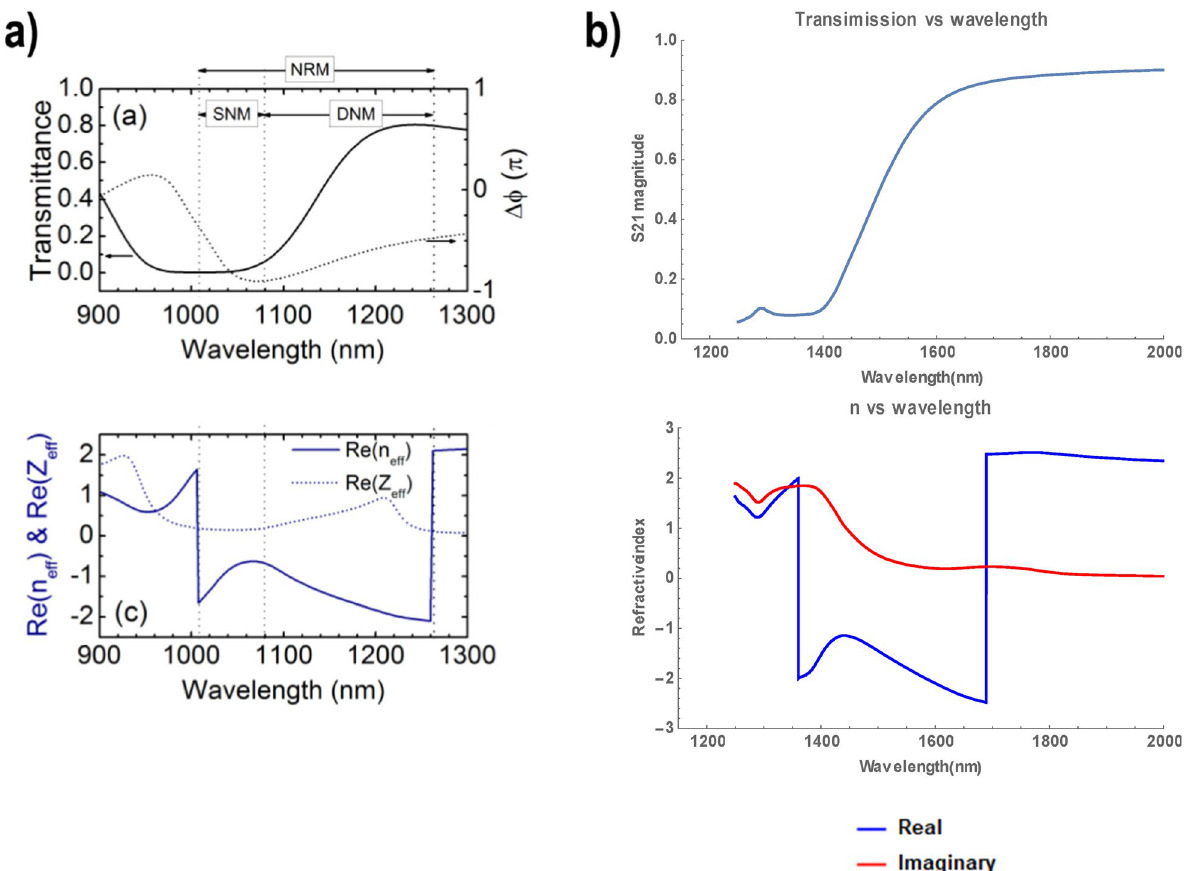
Figure 3. Comparison between Chan et al.’s simulation results 17 in ( a ) ([Reprinted/Adapted] with permission from 17 © IOP Publishing) of the upright split-ring pair metamaterial and our own results in ( b ).